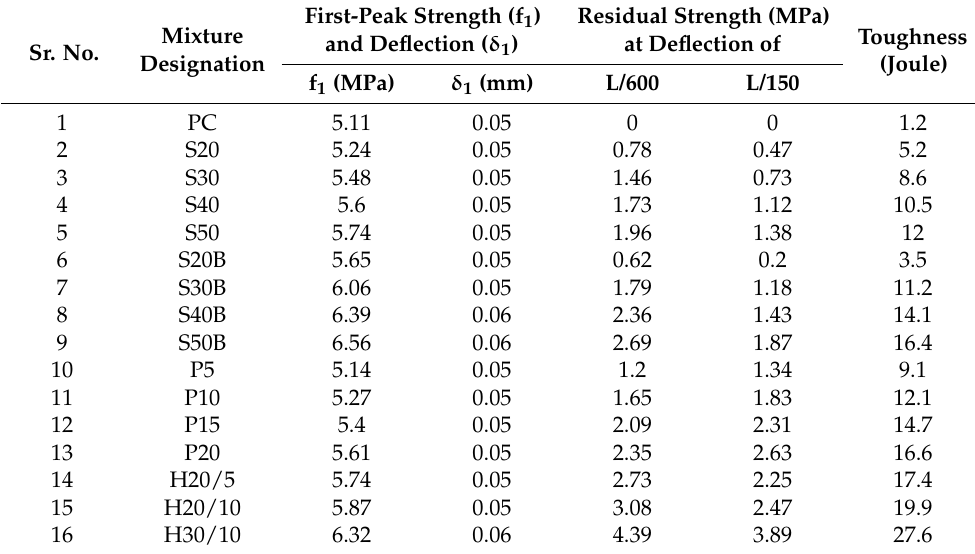
Table 5. Results of flexure